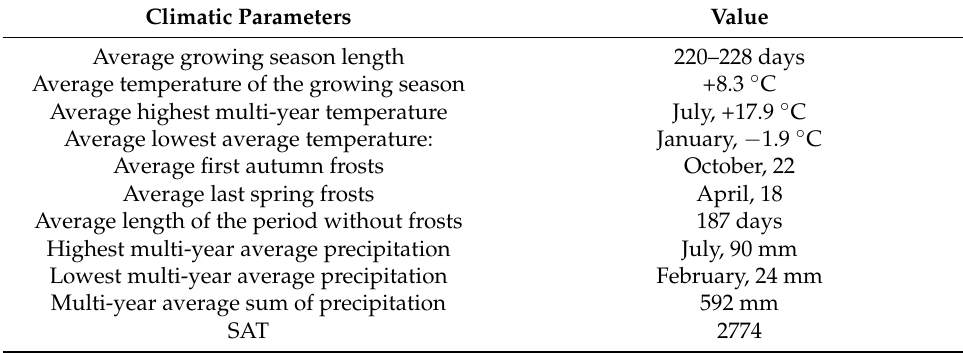
Table 1. Climatic conditions of the experimental